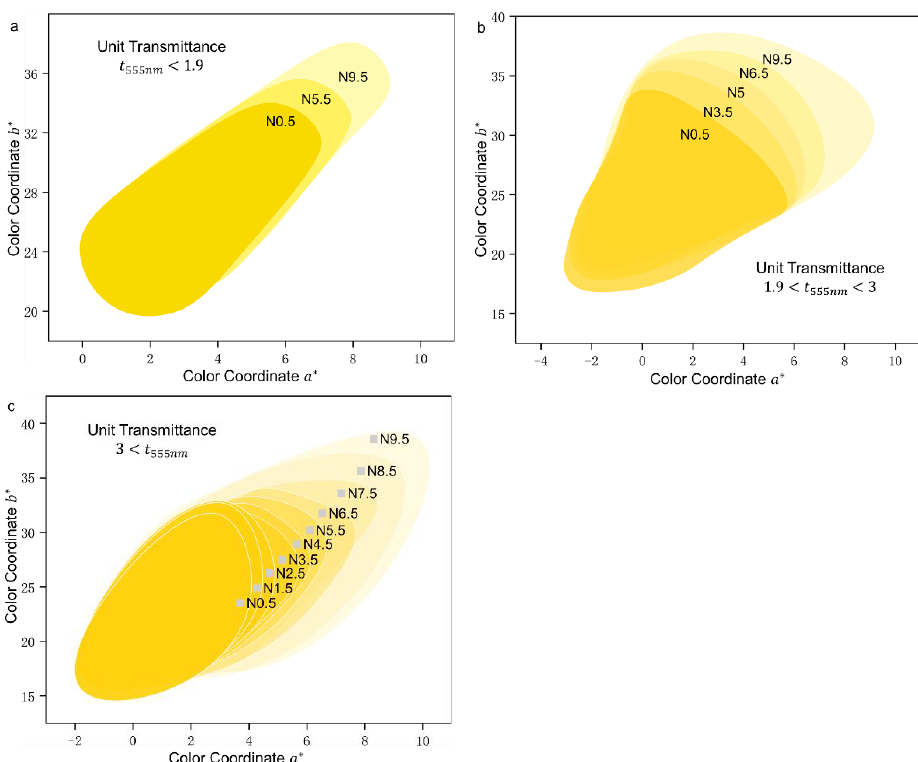
Figure 6. The 𝑎 ∗ 𝑏 ∗ casting point diagrams of every sample within a group under different back- ground. The color block represents the state of sample distribution in this background. ( a ) For sam- ple with t less than 1.9, the range of 𝑎 ∗ 𝑏 ∗ does not expend. For samples within the groups ( b ) 1.9 < t < 3 and ( c ) 3 < t , the range of 𝑎 ∗ 𝑏 ∗ gets wilder as the lightness of background increases. According to the conclusion above, the background has a significant effect on the color measurement, so it is crucial to select a neutral background during the measurement process. The Munsell N9.5 neutral value scale is a neutral background, while its high brightness allows for greater differentiation when measuring different samples. So, in this paper, we choose the N9.5 Value Scale as the color grading background for higher accu- racy. 3.4. The Color Grading Result of Yellow Jadeite on the N9.5 Background The 33 yellow jadeites ’ quantification was obtained on the Munsell N9.5 Value Scale, and the grading result was analyzed by AP and K-means, which is shown in Figure 7 with Lightness 𝐿 ∗ and Colorimetric Coordinate 𝑎 ∗ 𝑏 ∗ . The 33 samples were graded into 4 groups, and the cluster centers are shown in Table 1. Based on testing results, we imitated the GIA GTL grading description: Looking at two of the three attributes of color at one time, that is, tone (Lightness) and saturation (Chroma), there is a constant hue (Figure 8). The color of yellow jadeites was divided into Fancy, Fancy Intense, Fancy Deep, and Fancy Light. Figure 7. The three-dimensional casting diagram (Lightness 𝐿 ∗ , Colorimetric Coordinate 𝑎 ∗ 𝑏 ∗ ) of yellow jadeite based on the CIE1976 𝐿 ∗ 𝑎 ∗ 𝑏 ∗ uniform color space by AP and K-means cluster methods.